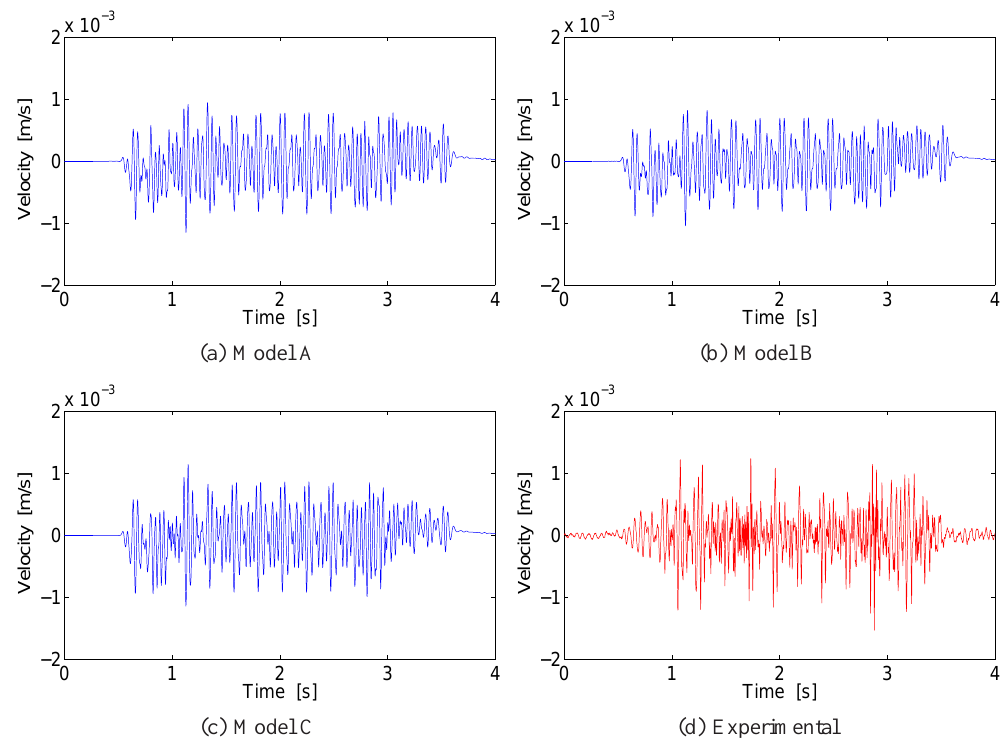
Figure 15. Predicted and measured time history of vertical ground velocity at 9m from the track.